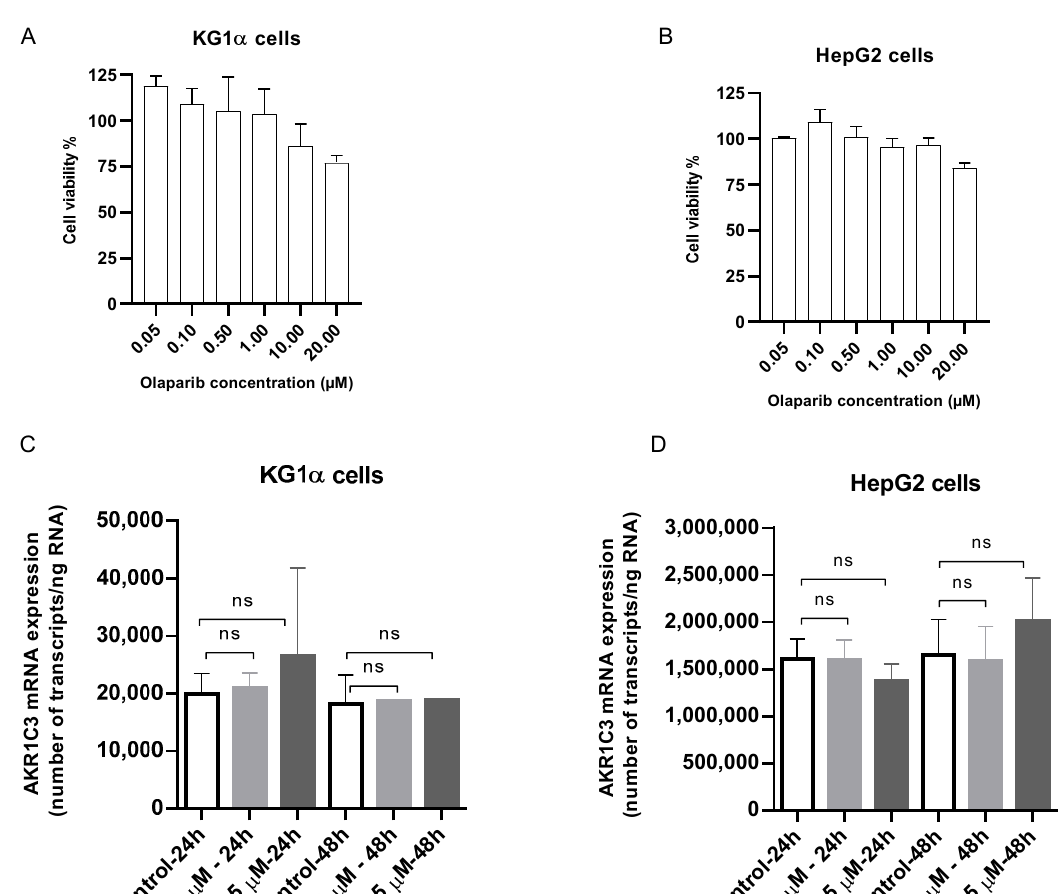
Figure 8. E ff ect of olaparib (0.05–20.00 µ M) on cell viability in ( a ) KG1 α cells and ( b ) HepG2 cells after 48 h exposure. Cell viability of 0% and 100% were assigned to cells incubated with 10% DMSO and vehicle control, respectively. GraphPad Prism 8.4.0 was used to perform normalization of absorbance values. Determination of AKR1C3 expression after exposure to olaparib (1 and 5 µ M) in ( c ) KG1 α cells and ( d ) HepG2 cells. After 24 h and 48 h, possible changes in AKR1C3 mRNA expression were monitored by quantitative reverse transcription real-time PCR (qRT-PCR). Student’s t -test (unpaired) was employed to assess statistical significance (ns: not significant). Data are presented as the means ± SD of three independent